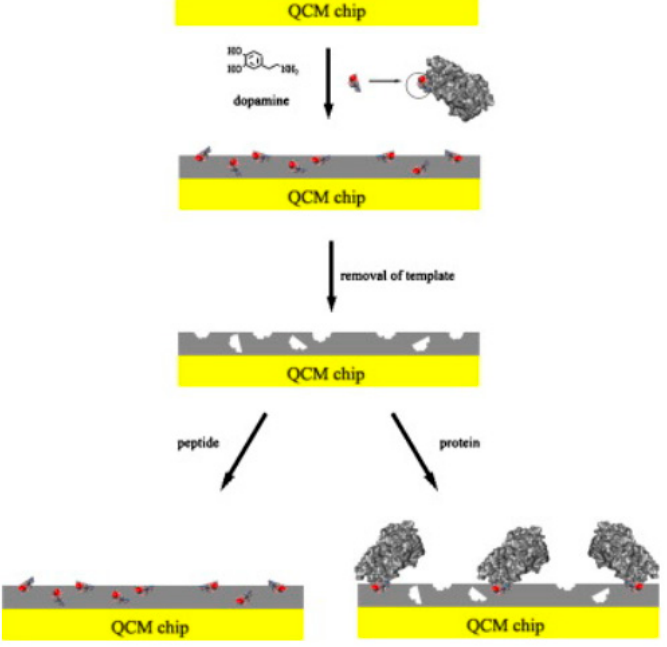
Figure 7. Schematic diagram of epitope imprinting. Dopamine was used as functional monomer and cross-linker. The synthetic peptide was embedded in the polydopamine film on the QCM sensor chip. After template removal step, the recognition sites which were complementary to the template peptide and able to recognize the whole protein were formed on the surface (reproduced from [66] with permission).